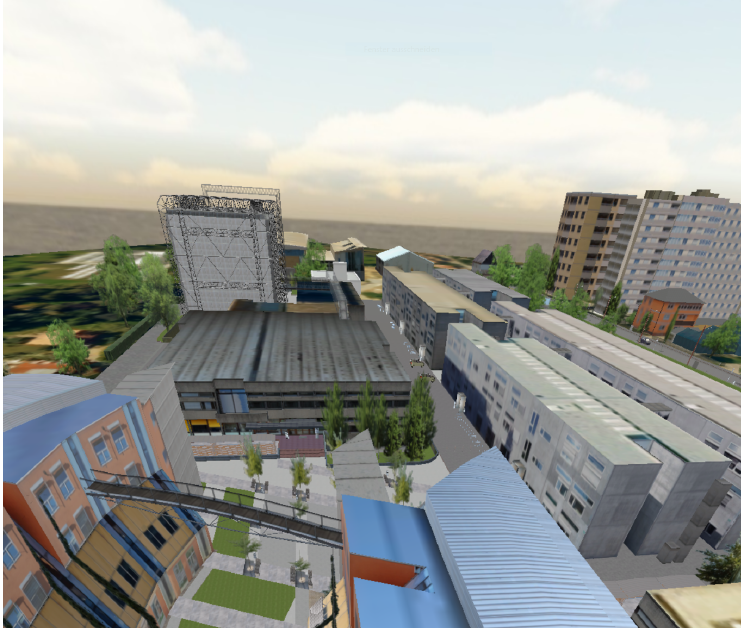
Figure 3. The test area for the drone consists of trees and buildings that serve as potential obstacles. The VR scene guarantees absolute control and thus reproducibility, but it will not contain any elements which have not been designed in